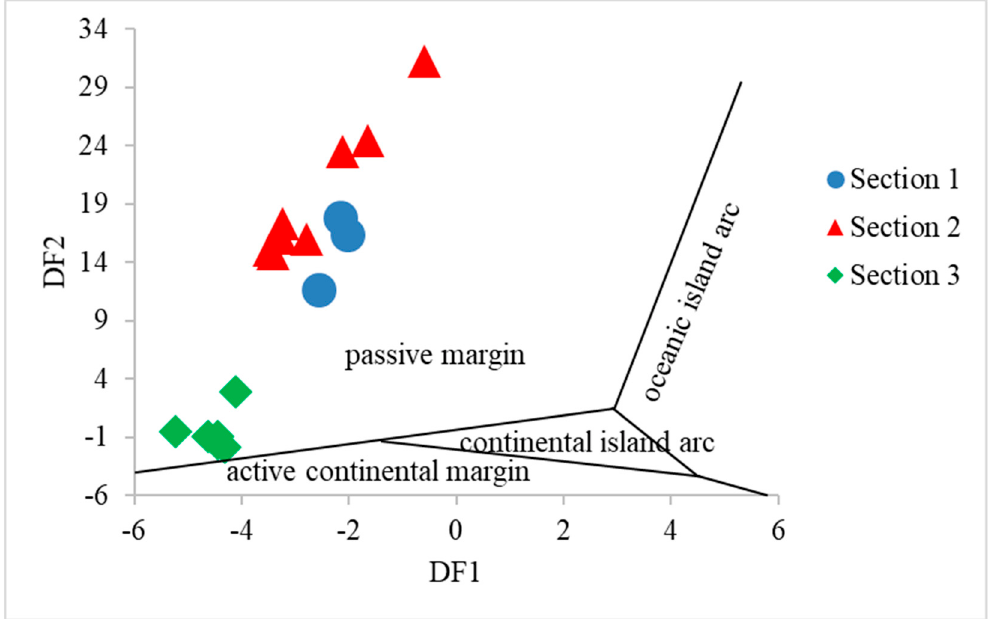
Figure 11. Discrimination function plot of the Chichali shales. Discrimination function 1 = 0.303 − 0.0447SiO 2 0.972TiO2 + 0.008Al 2 O 3 0.267Fe 2 O 3 + 0.14MgO + 0.195 CaO + 0.719Na 2 O − 0.032K 2 O. Discrimination function 2 = 43.57 − 0.421SiO 2 + 1.988TiO 2 − 0.526Al 2 O 3 − 0.551Fe 2 O 3 + 0.881MgO- 0.907CaO 0.177Na 2 O − 1.84K 2 O.